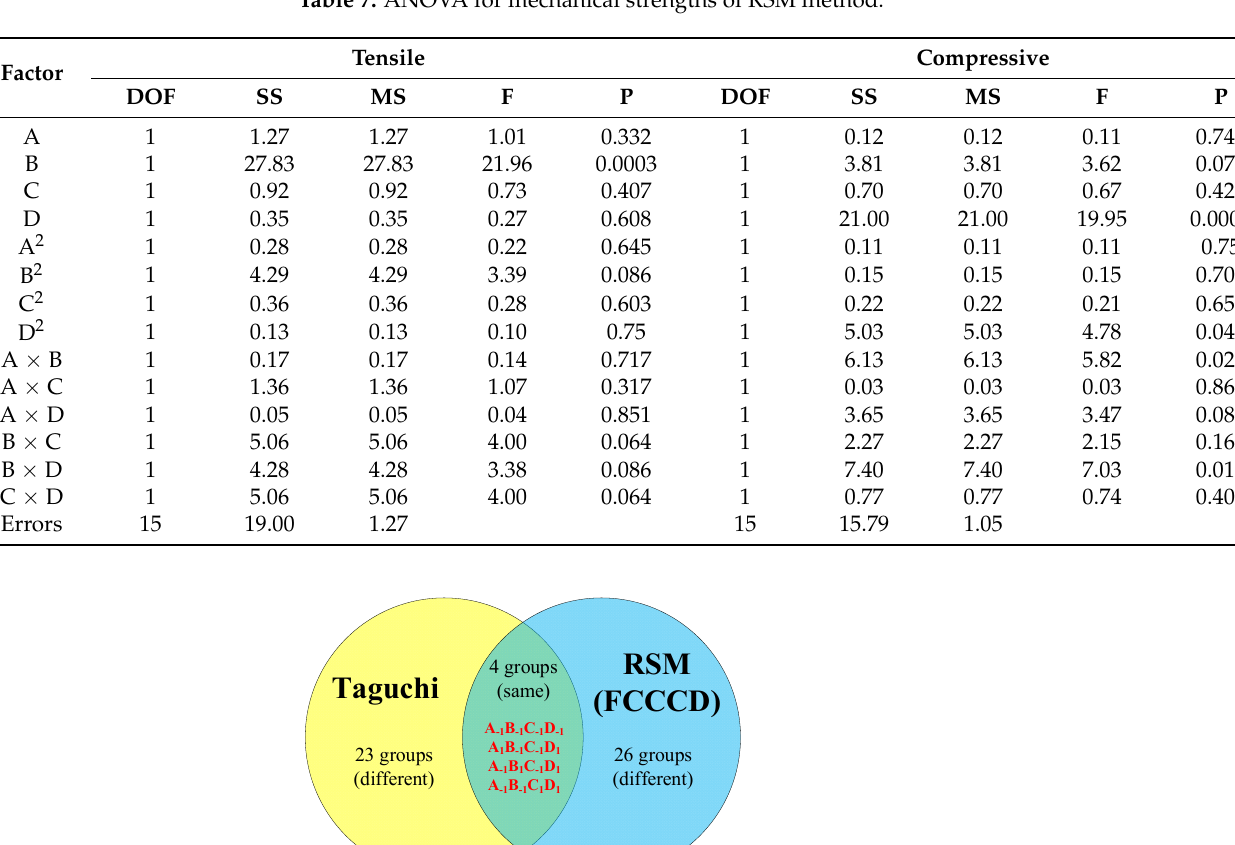
Figure 6. Normal probability plot of residual at 95% of confidence interval: ( a ) tensile strength, ( b ) compressive strength. Table 7. ANOVA for mechanical strengths of RSM method.